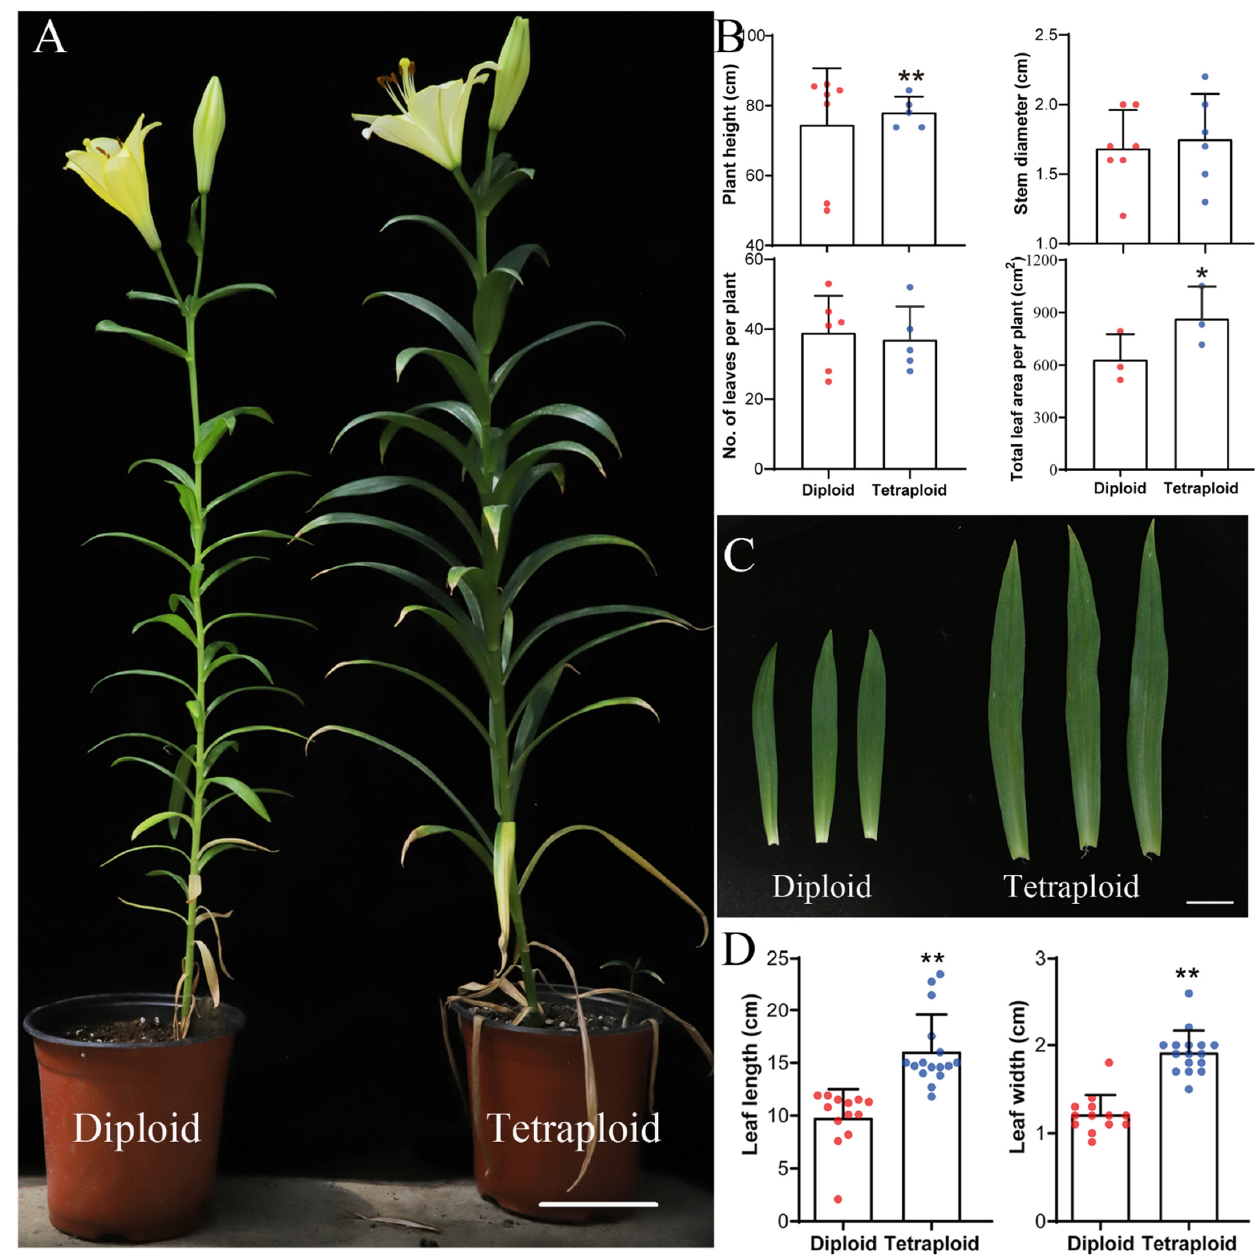
Figure 3. Morphological comparisons of allodiploid and allotetraploid lilies. ( A ) Allodiploids and allotetraploids at the flowering stage; bar = 5 cm. ( B ) Morphological comparisons of allodiploids and allotetraploids at the flowering stage. Error bars represent SDs ( n = 5–7). ( C ) Leaves of allodiploids and allotetraploids; bar = 2.5 cm. ( D ) Length and width of leaves of allodiploids and allotetraploids. Error bars represent SDs ( n = 11–15). Significant differences in plant height, leaf length, and leaf width between allodiploids and allotetraploids were determined by Student’s t ‐ test (*, p < 0.05; **, p < 0.01). The stomatal traits of the leaves of the allodiploid and allotetraploid plants were determined. The stomatal length and width of the leaves significantly increased after plants was significantly lower compared with that of the allodiploid